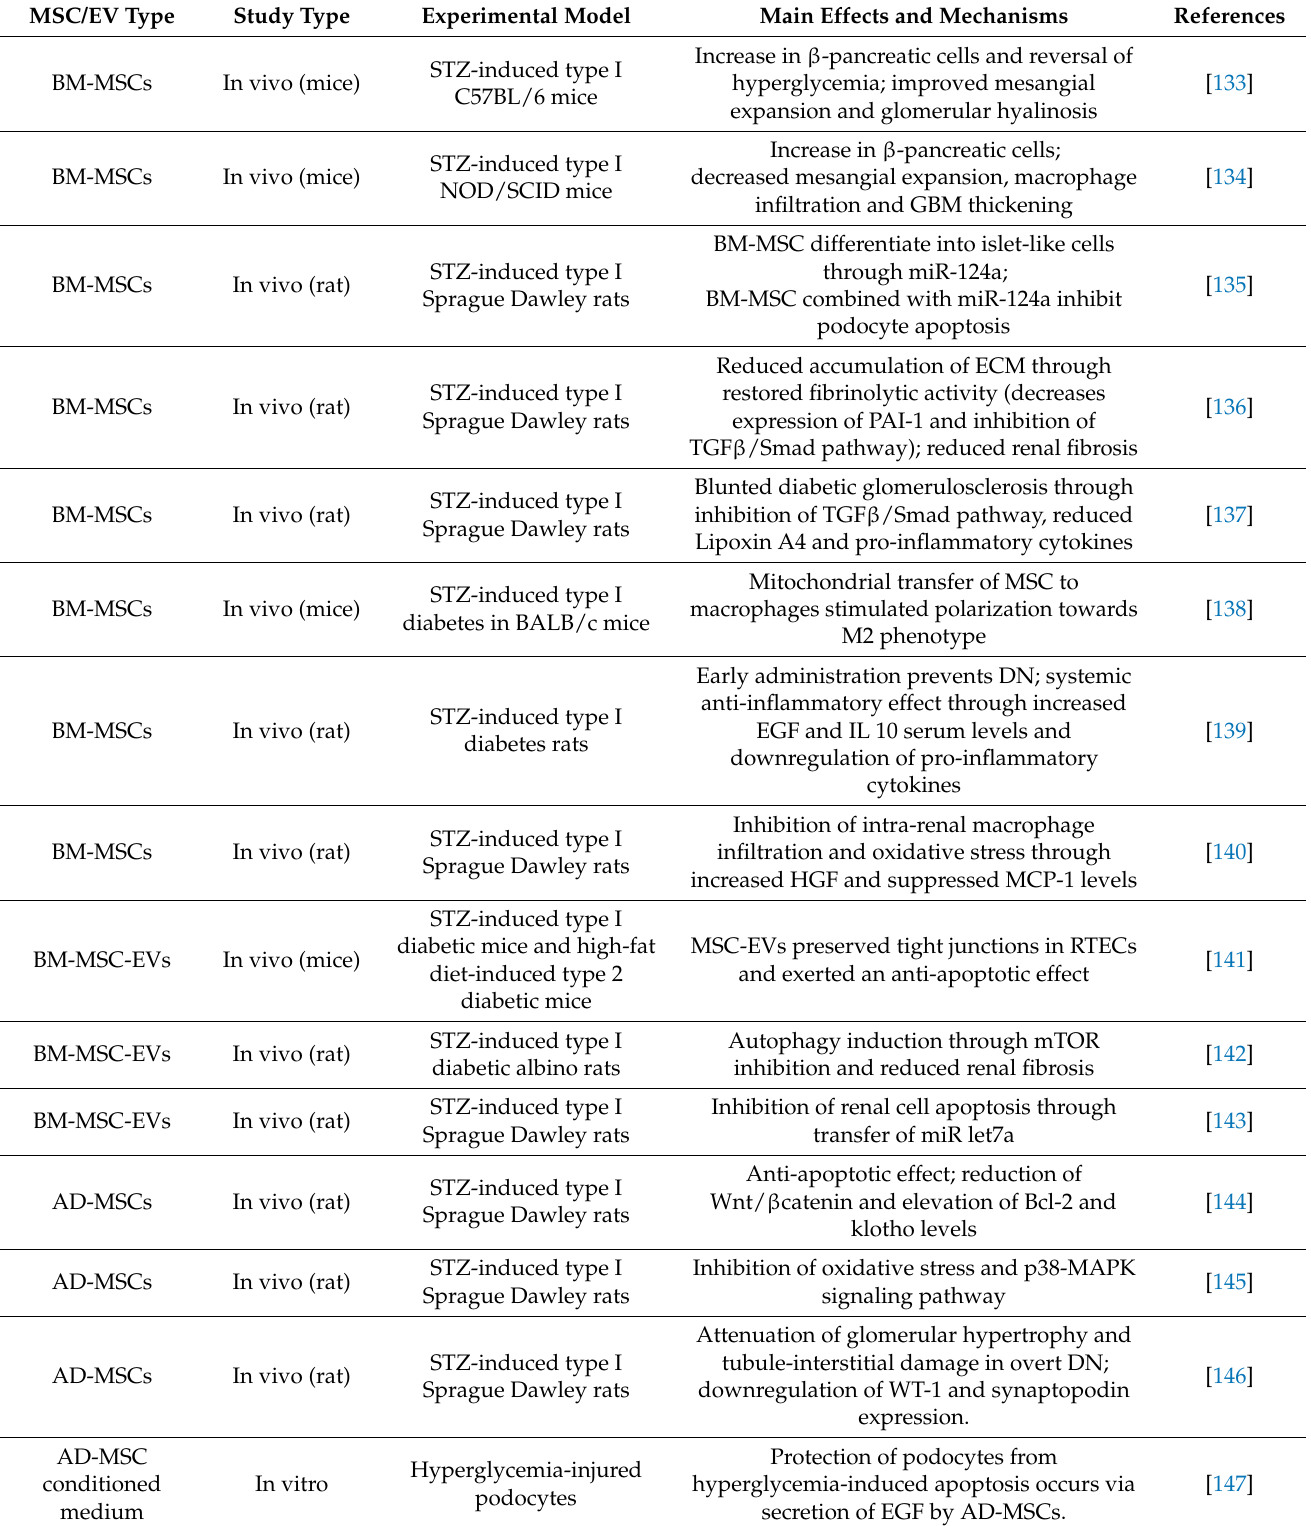
Table 3. Main pre-clinical studies of MSC and MSC-EV therapy in